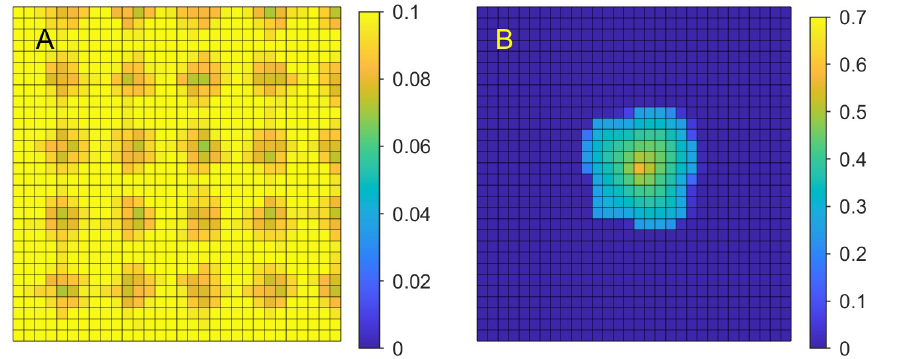
Fig 20. The ECM and tumor volume fractions over the domain. A: Non-homogeneous ECM. B: Asymmetrical tumor shape as a result of non-homogeneous ECM.